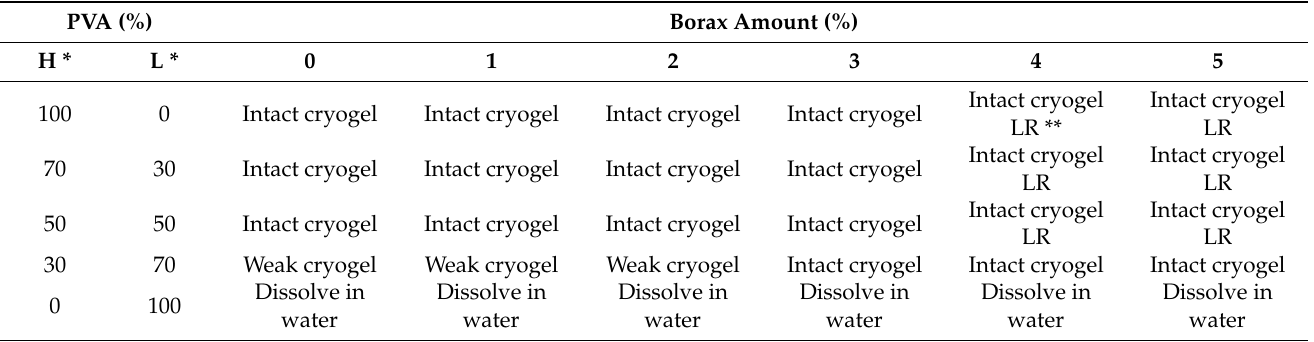
Table 1. Effect of PVA molecular weight and ratio and borax % on cryogelation